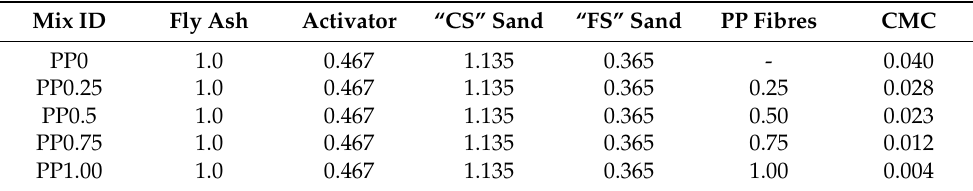
Table 2. The mix proportions of 3D-printed geopolymer mortars 1